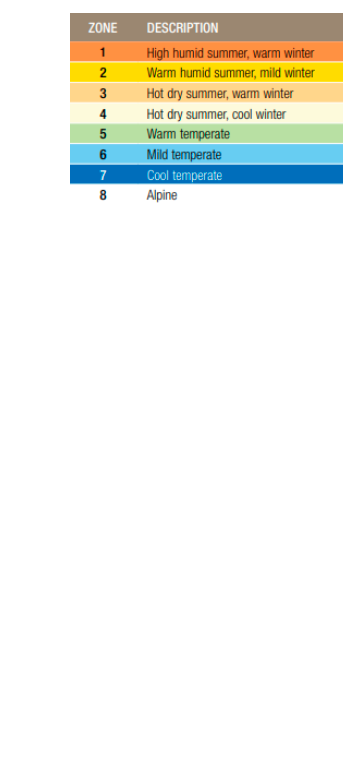
Figure 3. Australian climate zone map. [83,84]